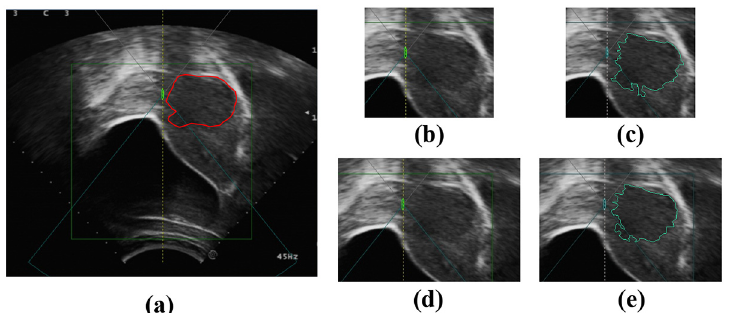
Fig 14. An example of tumor segmentation with a weak boundary in different ROIs. (a) The original image. (b) The first ROI image. (c) Segmentation result of (b). (d) The second ROI image. (e) Segmentation result of (d).